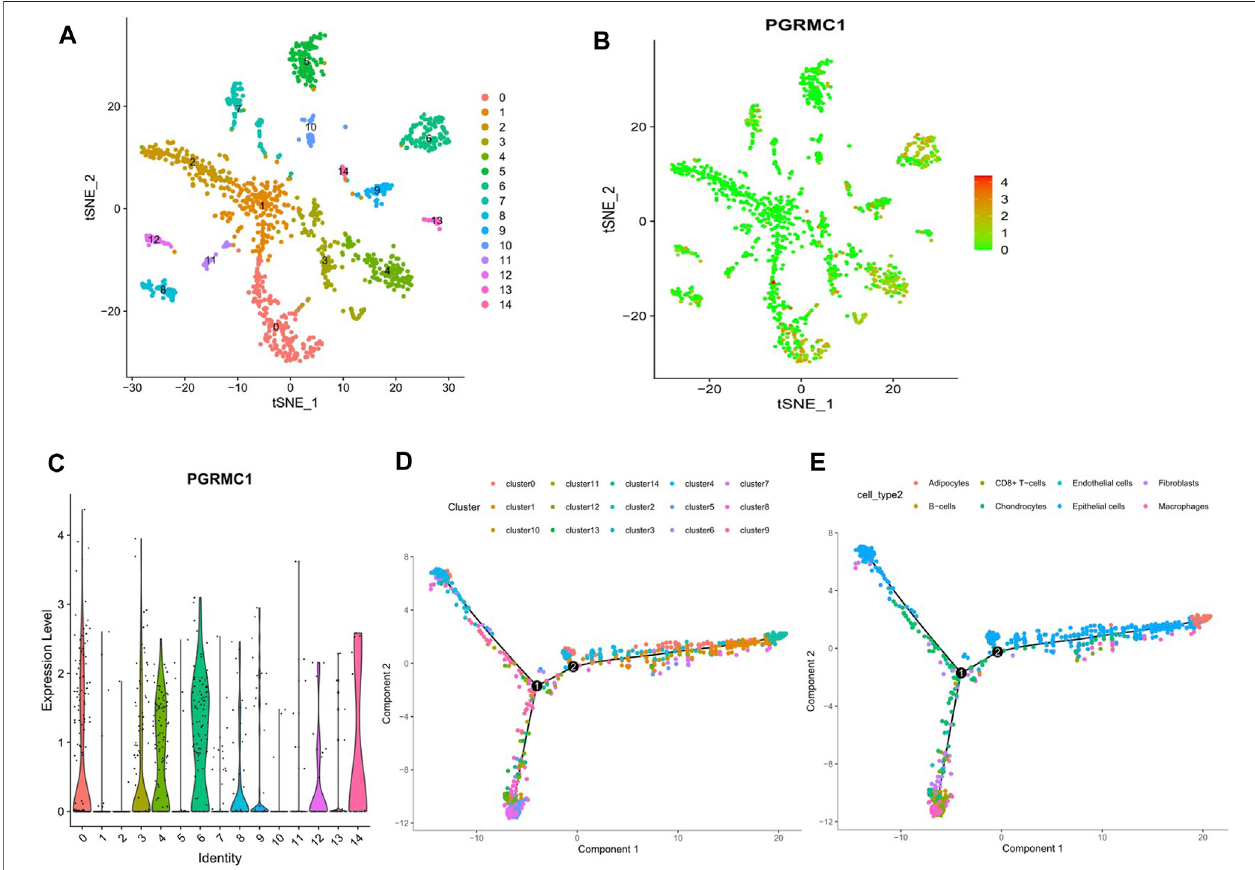
FIGURE 6 | Results of reanalyzed Single-cell RNA sequencing. (A) Single-cell RNA sequencing identi fi es 15 clusters of cells in TNBC tissues. (B, C) Expression of PGRMC1 mRNA in different clusters. (D) Single-cell trajectory analysis reveals cell developmental pathways. (E) Relevant annotation tracks.